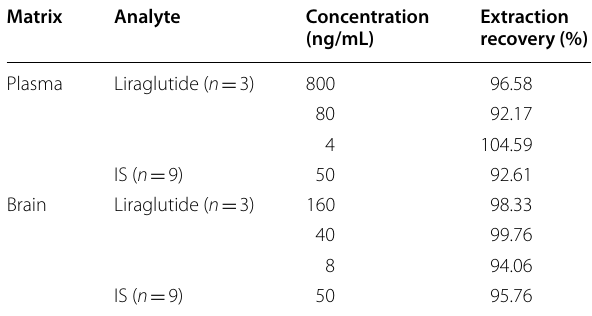
Table 3 Extraction recovery (%) of liraglutide and the internal standard (IS) in the rat plasma and brain tissue